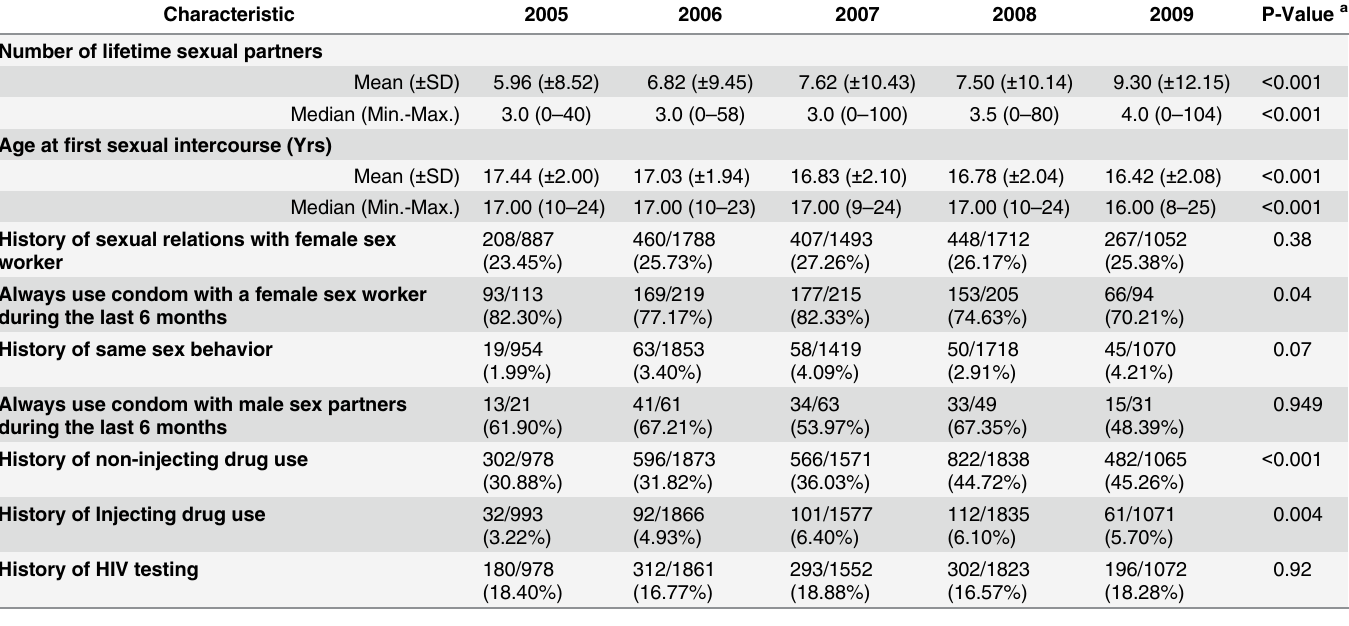
Table 2. Risk behaviors of sampled men by years of induction, from 2005 –